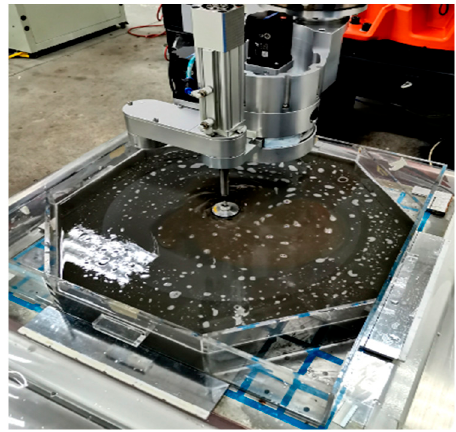
Figure 21. Photos of the rapid polishing process with center fl uid supply.